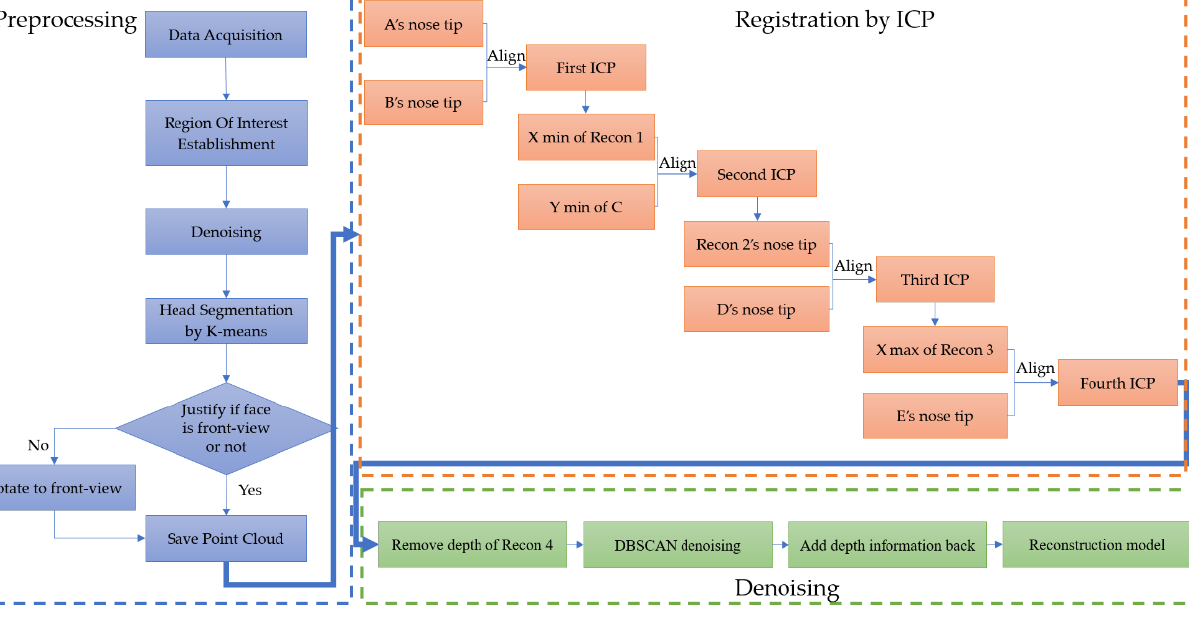
Figure 19. Flowchart of 3D point cloud facial reconstruction, the blue block diagram shows the preprocessing steps, the orange block diagram shows the registration steps and the green block diagram shows the denoising procedures.